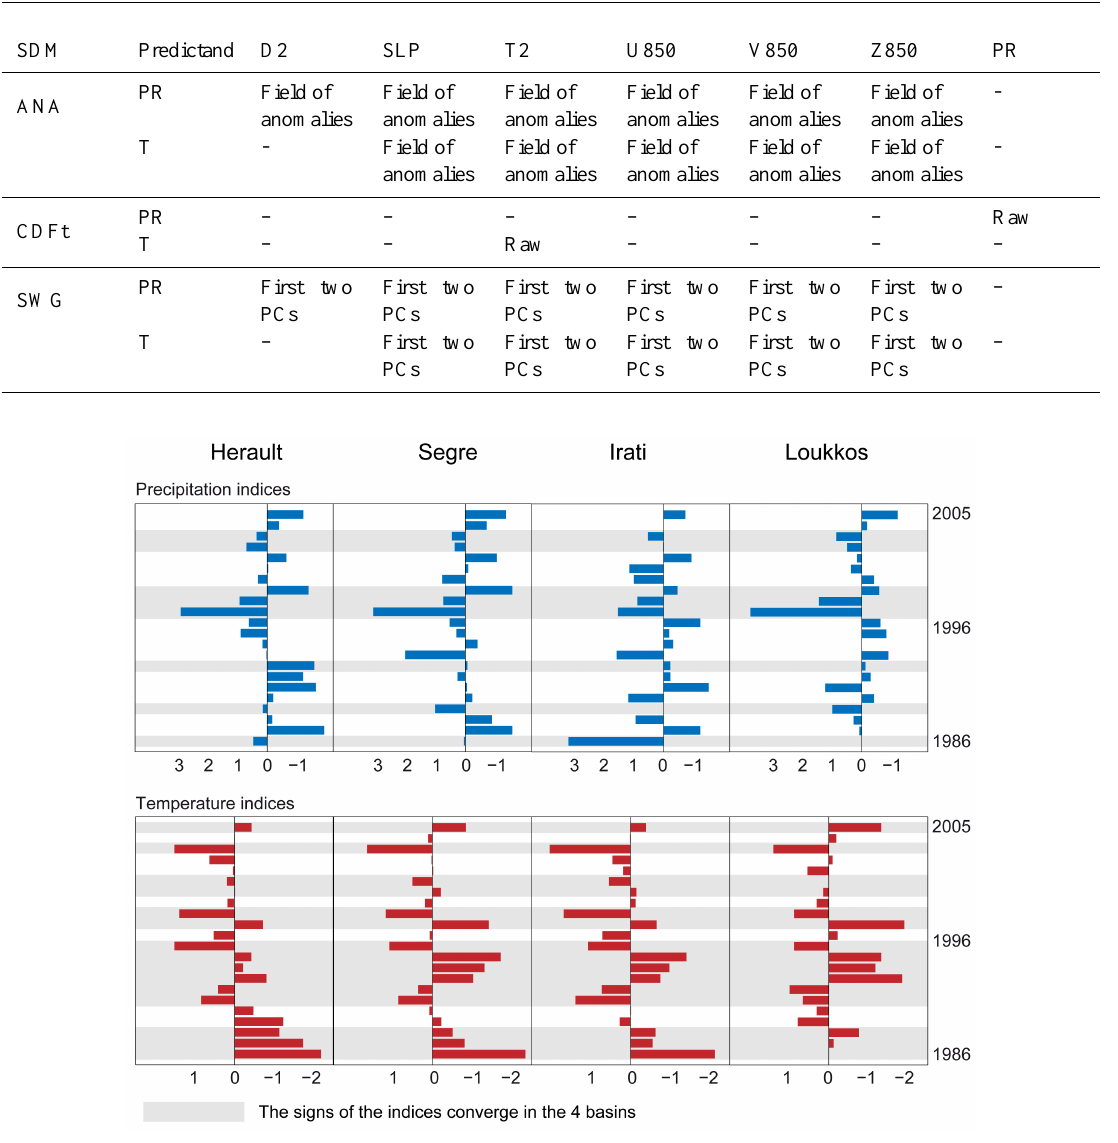
Table 1. Selected predictors according to the SDM and the predictand. These variables are the dew point at 2m (D2), the temperature at 2m (T2), the sea level pressure (SLP), the relative humidity, the zonal and meridional wind components, the geopotential height at the 850hPa pressure level (R850, U850, V850 and Z850) and the large-scale precipitation (PR). The pre-processing (PC) of the predictors depends on the SDM.